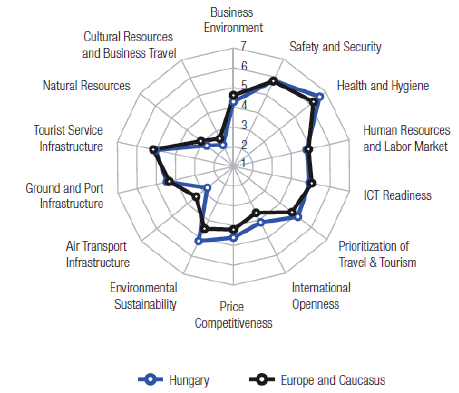
Fig.2 WEF TTCI Country Profile of Hungary The performance on the single indicators composing each pillar (1 to 7 scale, 1= worst score, 7 = best score) Source: WEF TTCI 2015